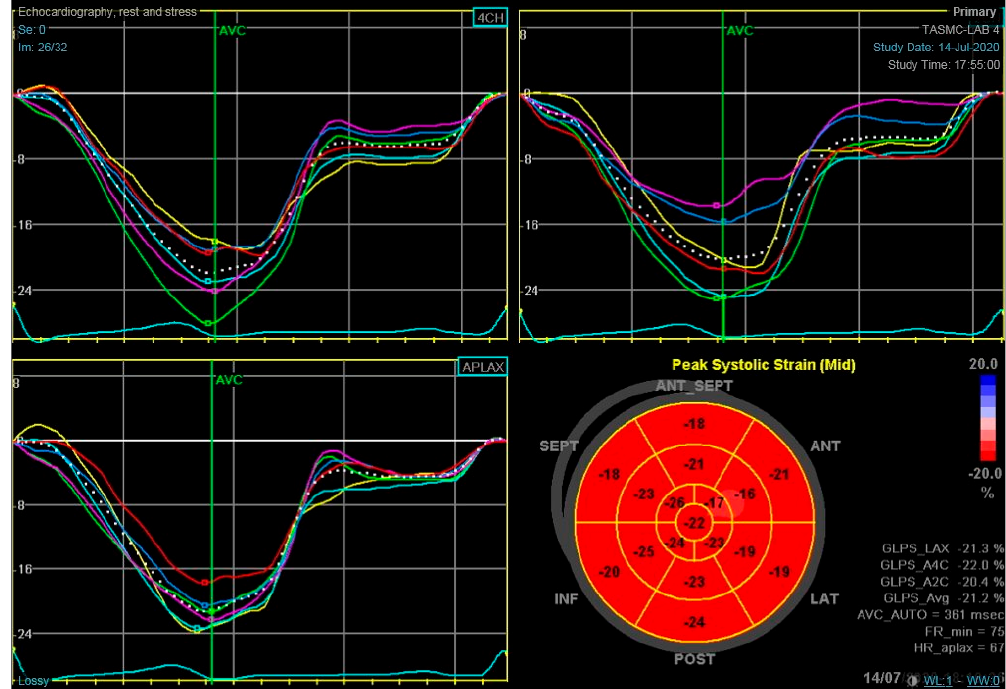
Figure 1. Left ventricle global longitudinal strain measurement GLS was assessed in three apical views, 4 chamber, 2 chamber and 3 chamber views, with 6 segments measured per each view (presented in the different colors), with a total of 18 segments per each exam.